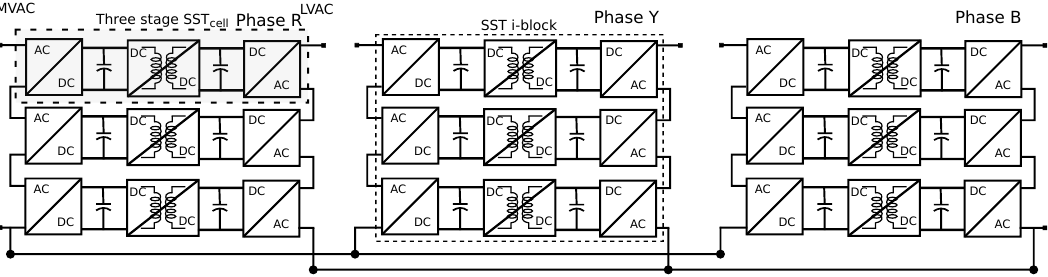
Figure 21. Fully phase modular SST as presented in [54].